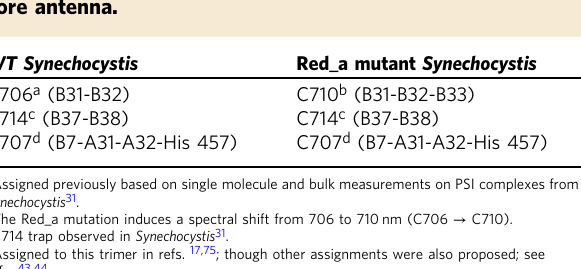
Table 1 Assignment of low-energy states to Chls in the PSI core